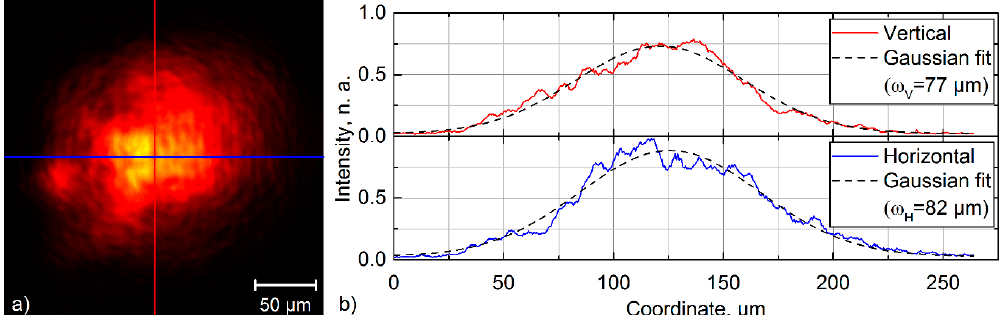
Figure 1. ( a ) Intensity profile of one of two interfering beams measured with a beam-profiling camera on the samples’ surface; ( b ) vertical and horizontal cross-sections of the laser intensity profile— 𝜔 (cid:3009) , 𝜔 (cid:3023) —correspond to the horizontal and vertical spot radius derived from the Gaussian fit, respectively.